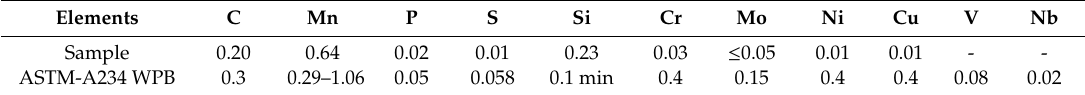
Table 2. The chemical composition of the sample and its corresponding ASTM standard values. Elements